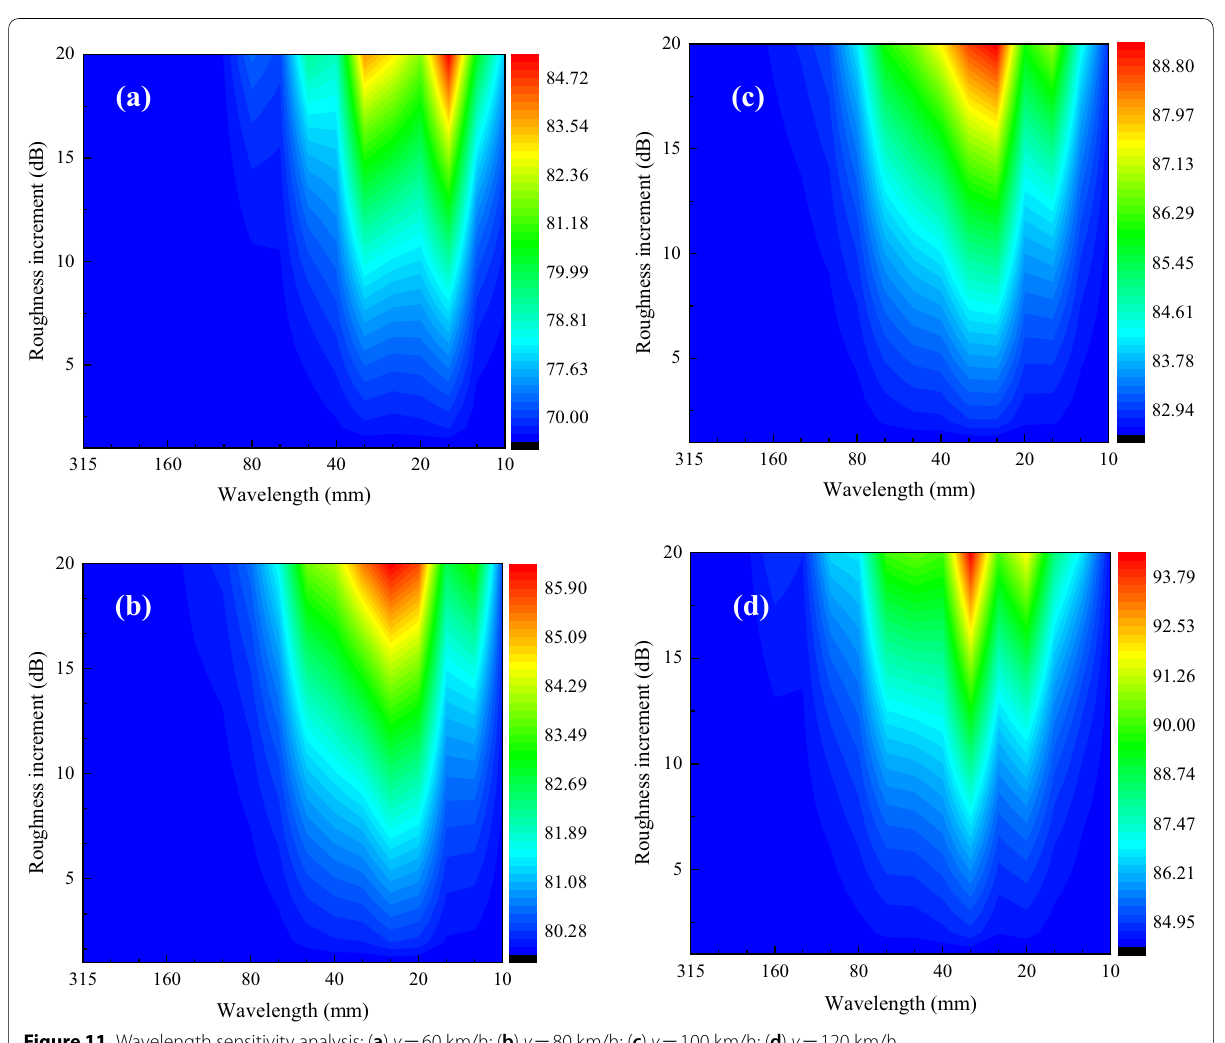
Figure 11 Wavelength sensitivity analysis: ( a ) v